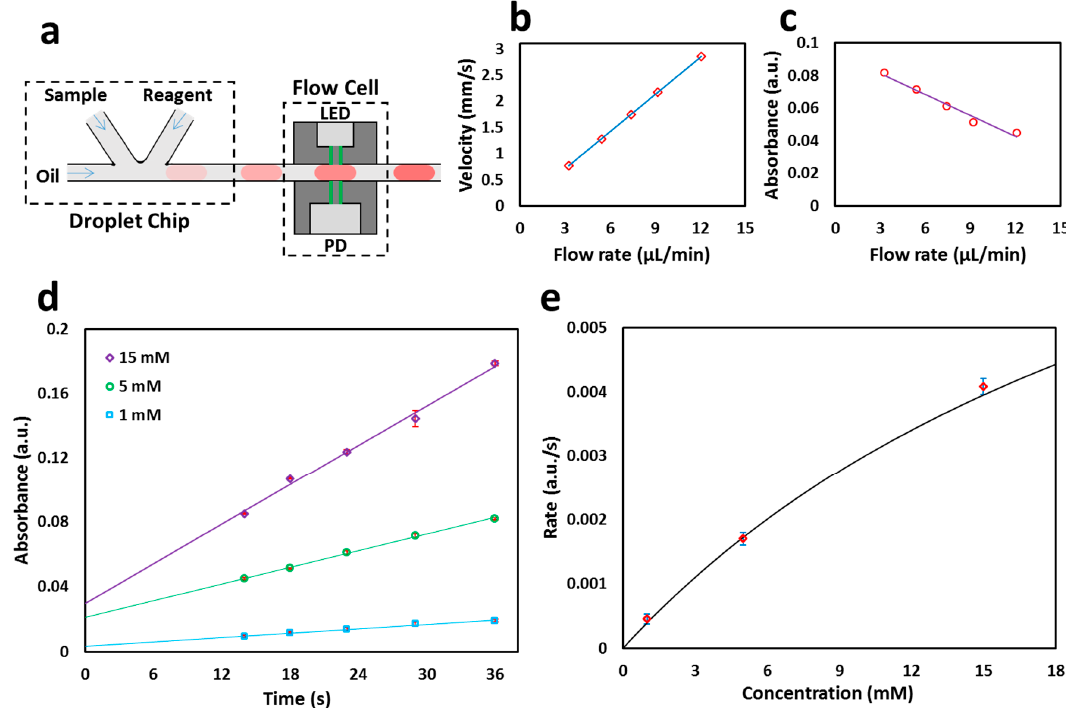
Figure 5. Enzymatic glucose reaction in droplets at different velocities: ( a ) Schematic of the droplet generation and injection into the flow cell; ( b ) Change in velocity versus total flow rate change. Each point corresponds to velocities of 0.77, 1.28, 1.75, 2.17 and 2.85 mm/s and flow rates of 3.3, 5.4, 7.4, 9.2, and 12.1 μ L/min at a distance of 3.8 cm; ( c ) Absorbance of 5 mM glucose decreases with increase in flow rate as the glucose reaction droplet reaches the detector in shorter times; ( d ) The absorbances of glucose droplets (1, 5, 15 mM) plotted as lines of best fit against time; ( e ) The data is fitted by nonlinear regression with a Michaelis–Menten curve. V max = 0.0068 a.u./s and K m = 10.77 mM.